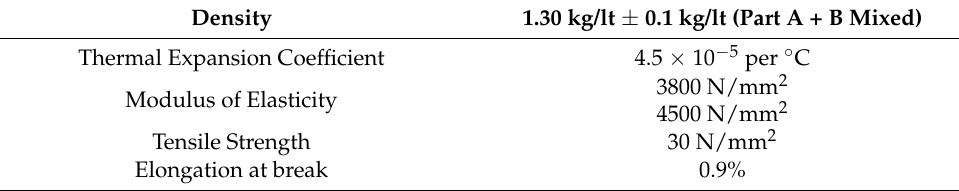
Table 2. Technical Data of the Epoxy